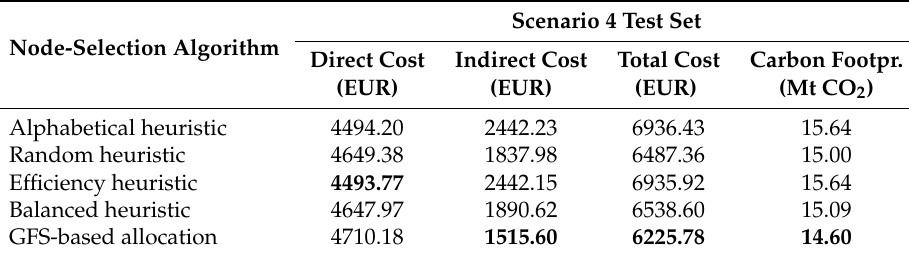
Table 6. Experiment results for the test set of Scenario 4.